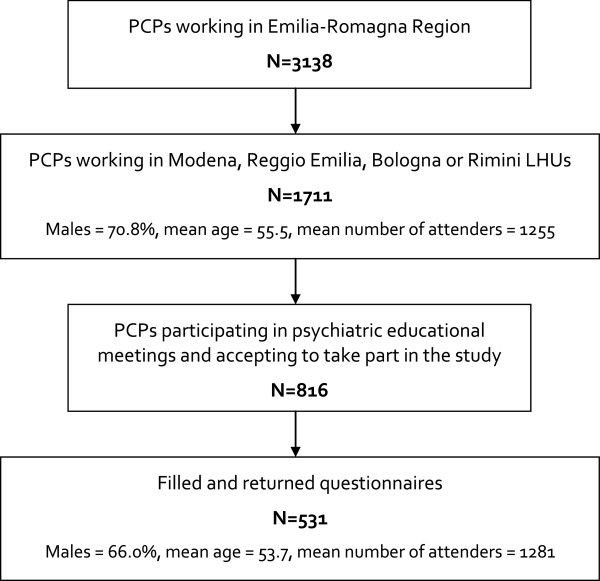
Flow diagram of the study.